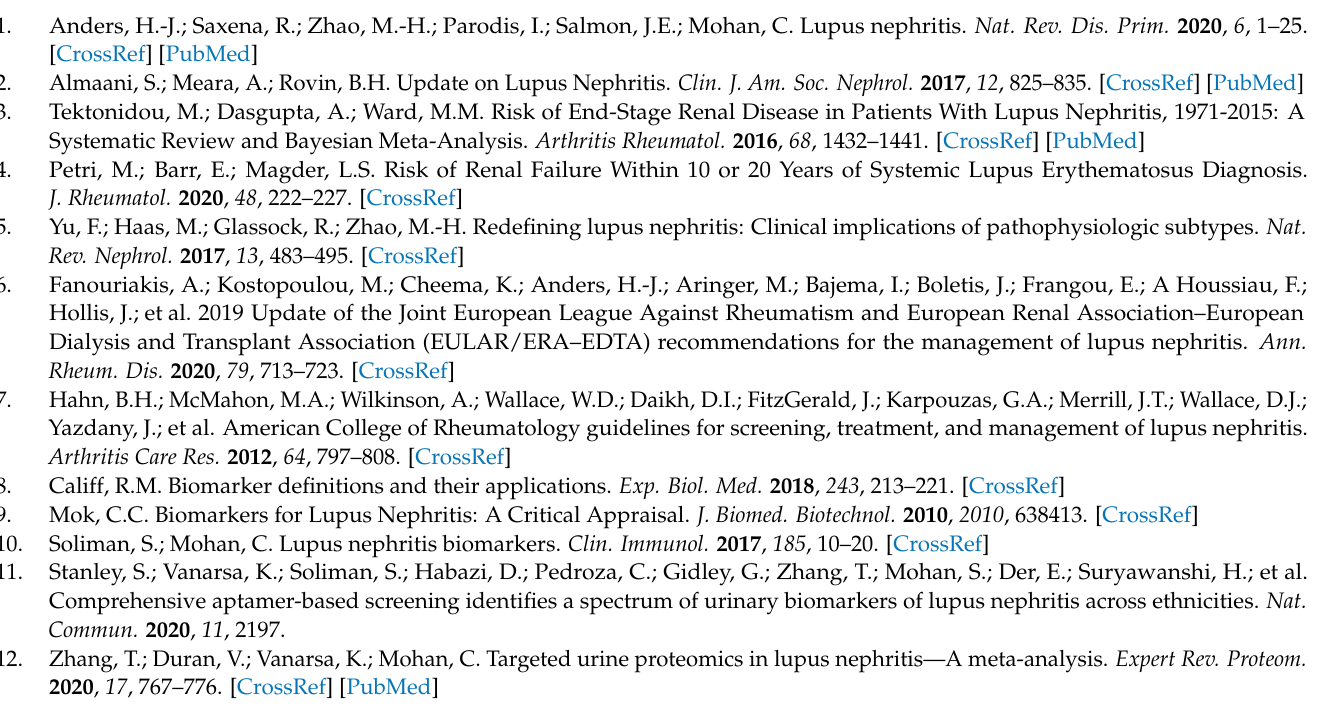
Table S4. Risk of bias assessment of cohort studies. Table S5. Ethnicity and/or nationality of the populations in the included